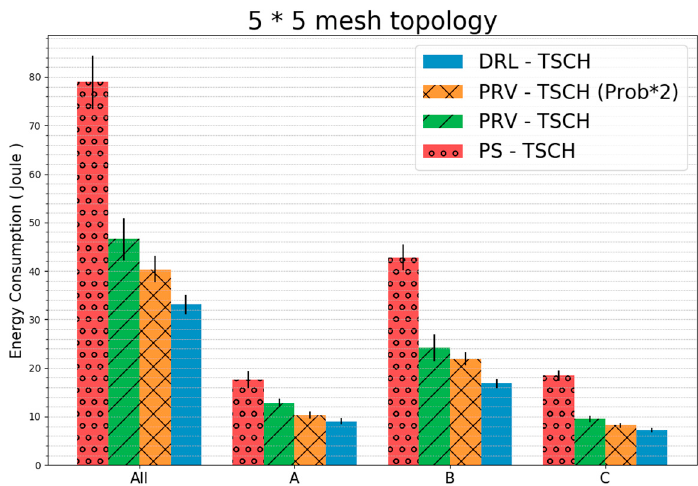
Figure 18. Energy Consumption During Synchronization in 5 × 5 Mesh Topology (standard error).